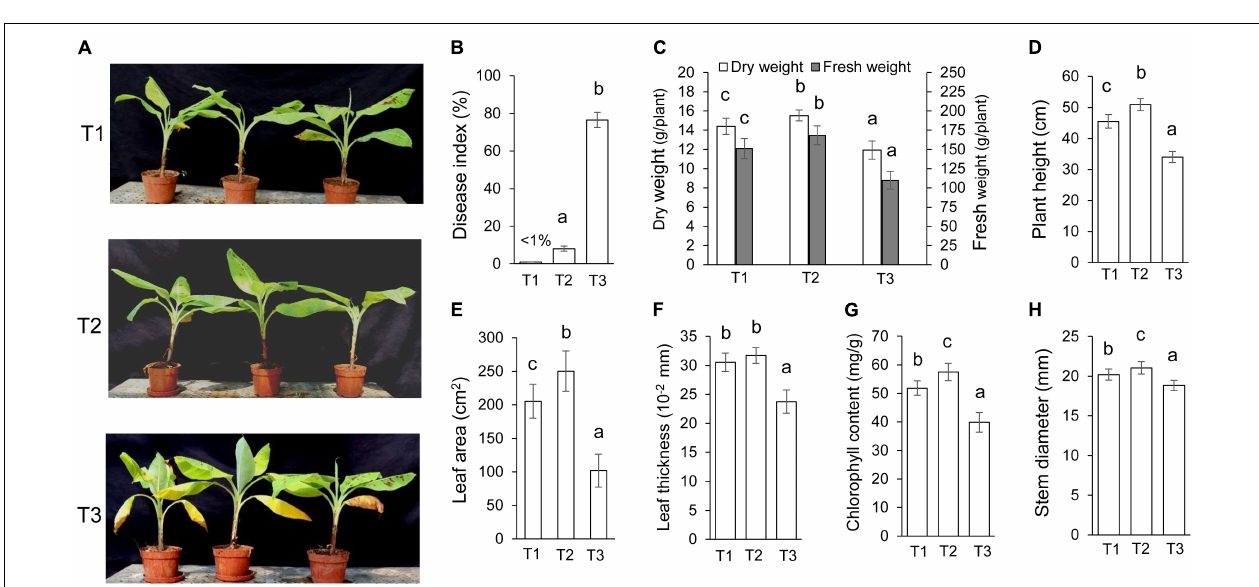
FIGURE 4 | Stability evaluation of the Streptomyces BITDG-11 extract after treatment at different temperatures (A) , pH values (B) , and UV doses (C) . Data are the mean values from three biological repeats. Different lowercase letters indicated a significant difference of antifungal activity in comparison with the control (LSD’s multiple range test, p < 0.05).